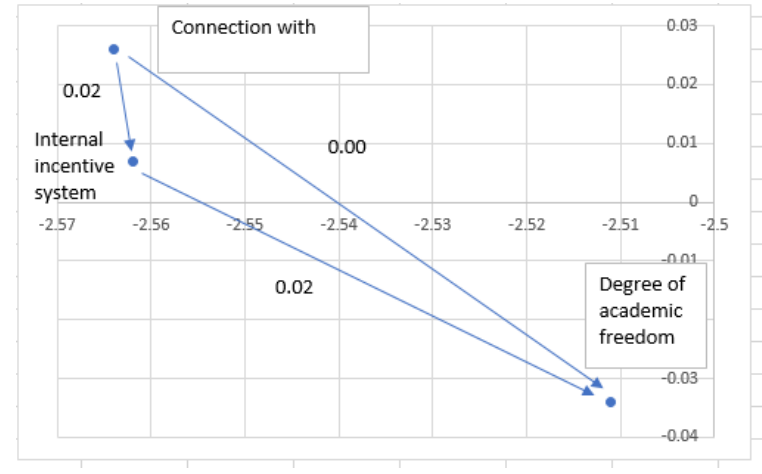
Figure 4. Causal diagram of sub-aspects of organizational structure and system.